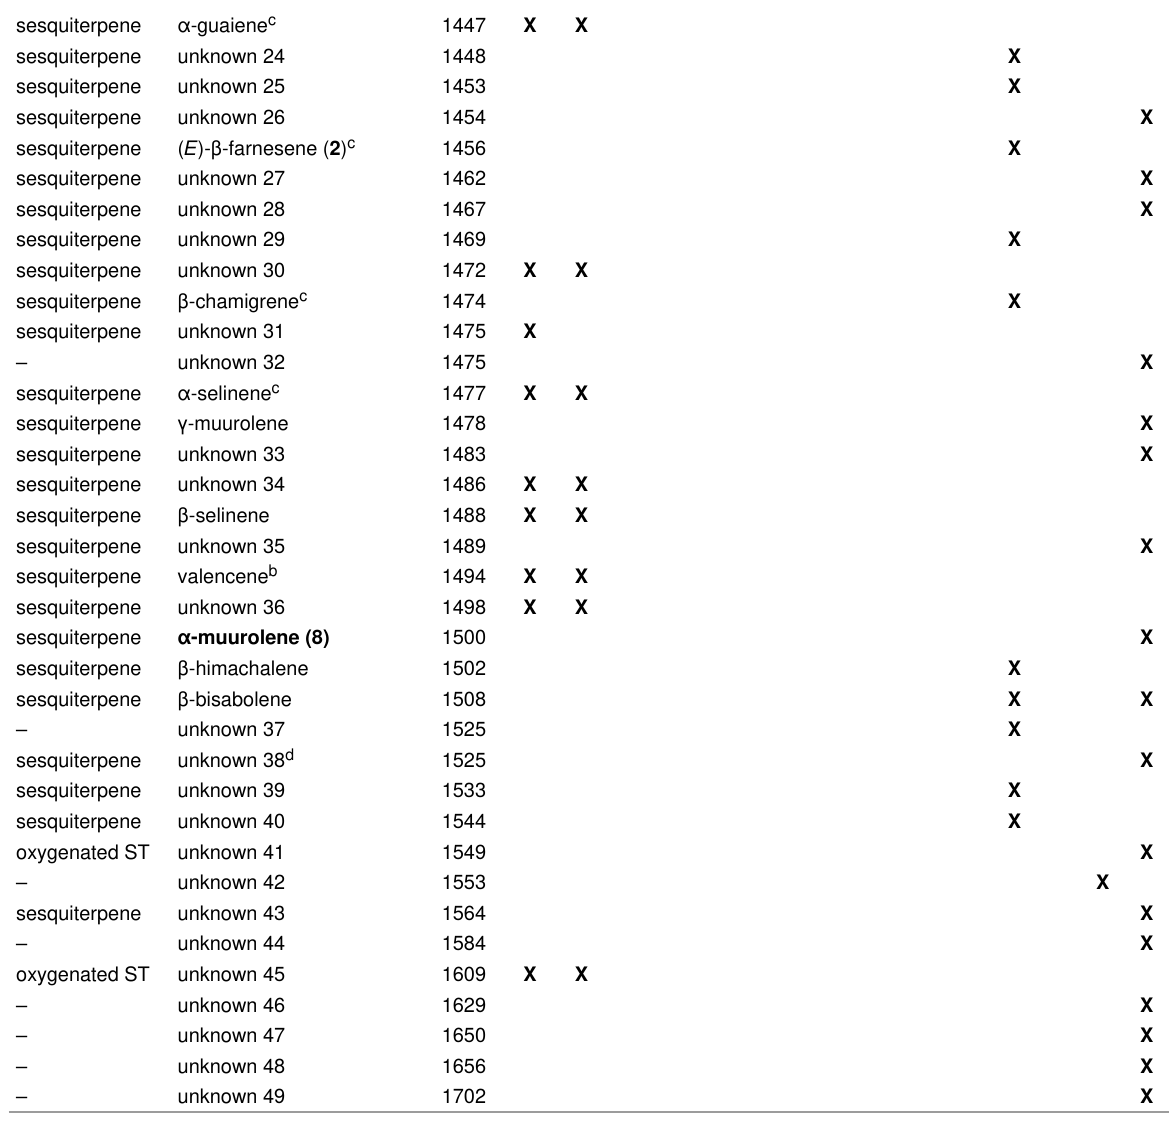
Table 2: Volatiles emitted from endophytic fungi growing in culture on potato dextrose agar (PDA). a (continued) sesquiterpene